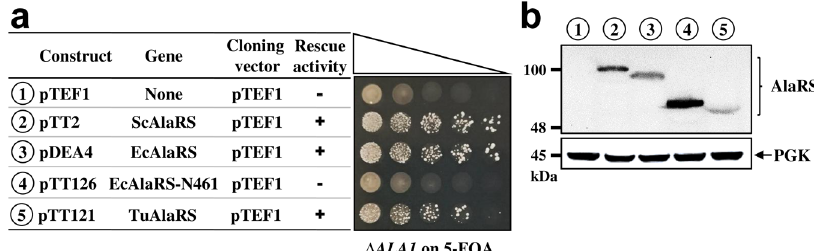
Fig. 4 Rescue of a yeast ALA1 KO strain by TuAlaRS. a Complementation assay. TuAlaRS ’ s rescue activity was determined by transforming the test plasmid into a yeast ALA1 KO strain and plating the resultant transformants on 5-FOA. The symbols “ + ” and “ − ” denote positive and negative complementation, respectively. b Western blotting. The protein expression levels of these constructs were determined by Western blotting using an anti- His 6 -tagged antibody as the probe. Constructs used in ( a , b ) are numbered for clarity.